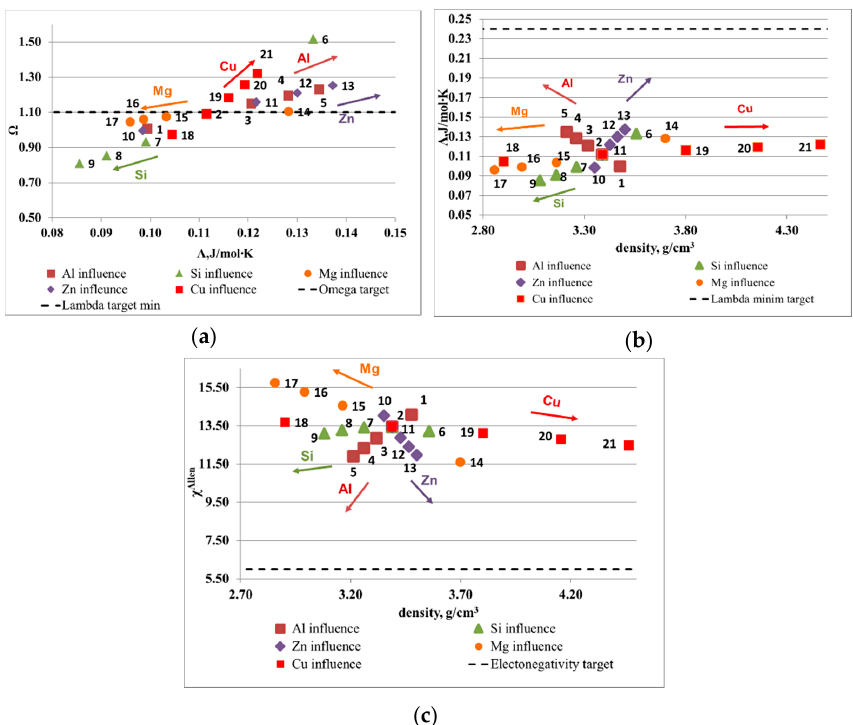
Figure 1. Elemental influence over the criteria values for Al-Cu-Si-Zn-Mg system: ( a ) Λ versus Ω , ( b ) Λ versus density, and ( c ) ∆ χ Allen versus density.